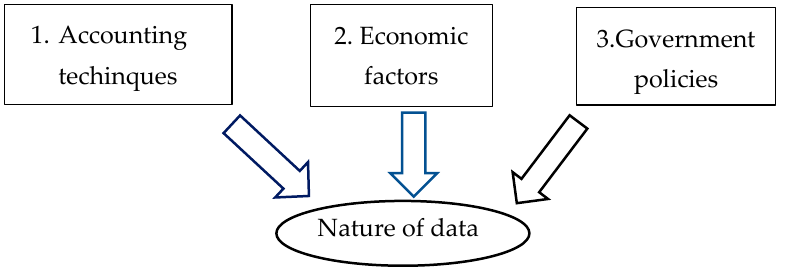
Figure 2. Factors shaping organizational data .